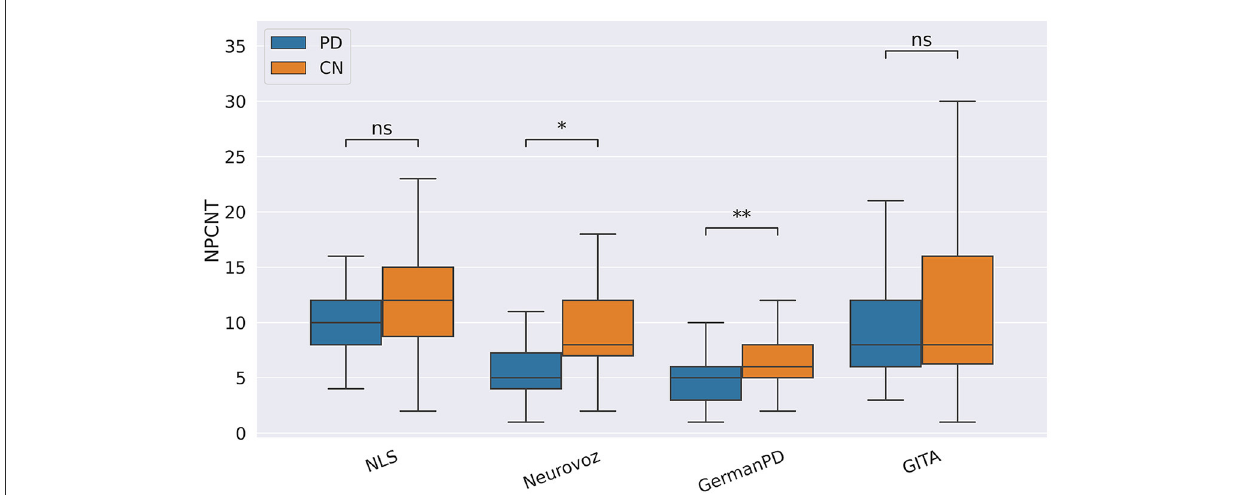
FIGURE5 Boxplots with statistical annotations representing the noun phrase count (NPCNT) on NLS, Neurovoz, GermanPD, and GITA from the SS task. Horizontal lines represent the median, the top ends represent the upper quartile, and the bottom ends represent the lower quartile. Statistically significant differences between groups after Benjamini–Hochberg correction for NPCNT are reported in Table 6 and highlighted below using asterisks. NPCNT, noun phrase count; CN, controls; PD, Parkinson’s disease; SS, spontaneous speech; ns, not significant.